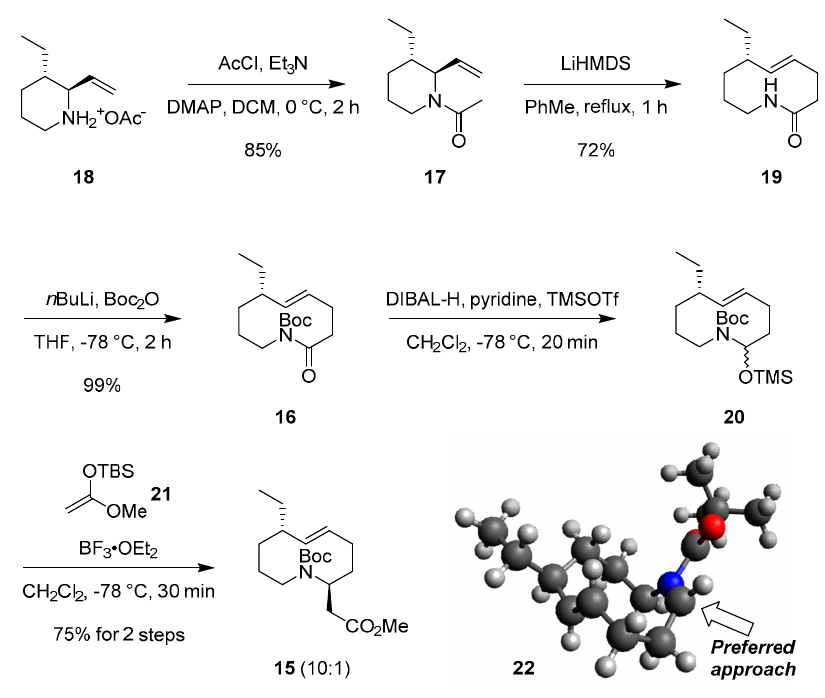
Scheme 2. Preparation and diastereoselective amidoalkylation of 16 .